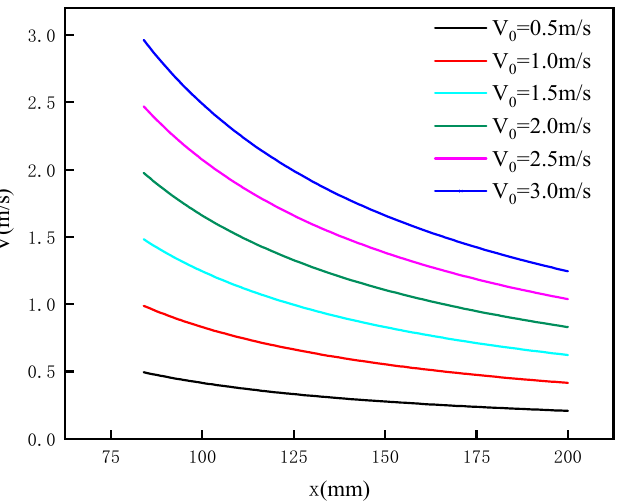
Figure 8. The velocity change of the air flow along the x direction with different initial velocity.